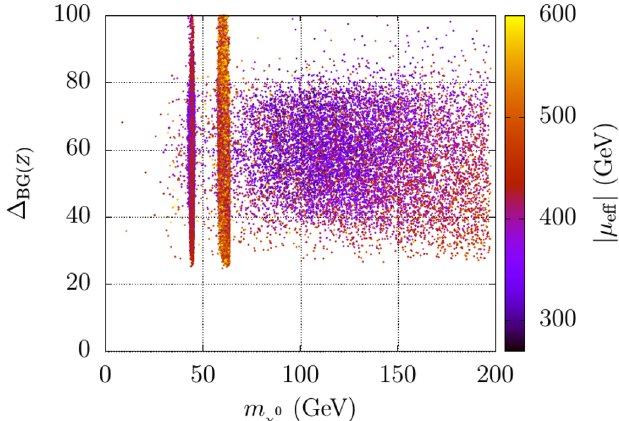
as a function of the LSP mass m BG( Z )